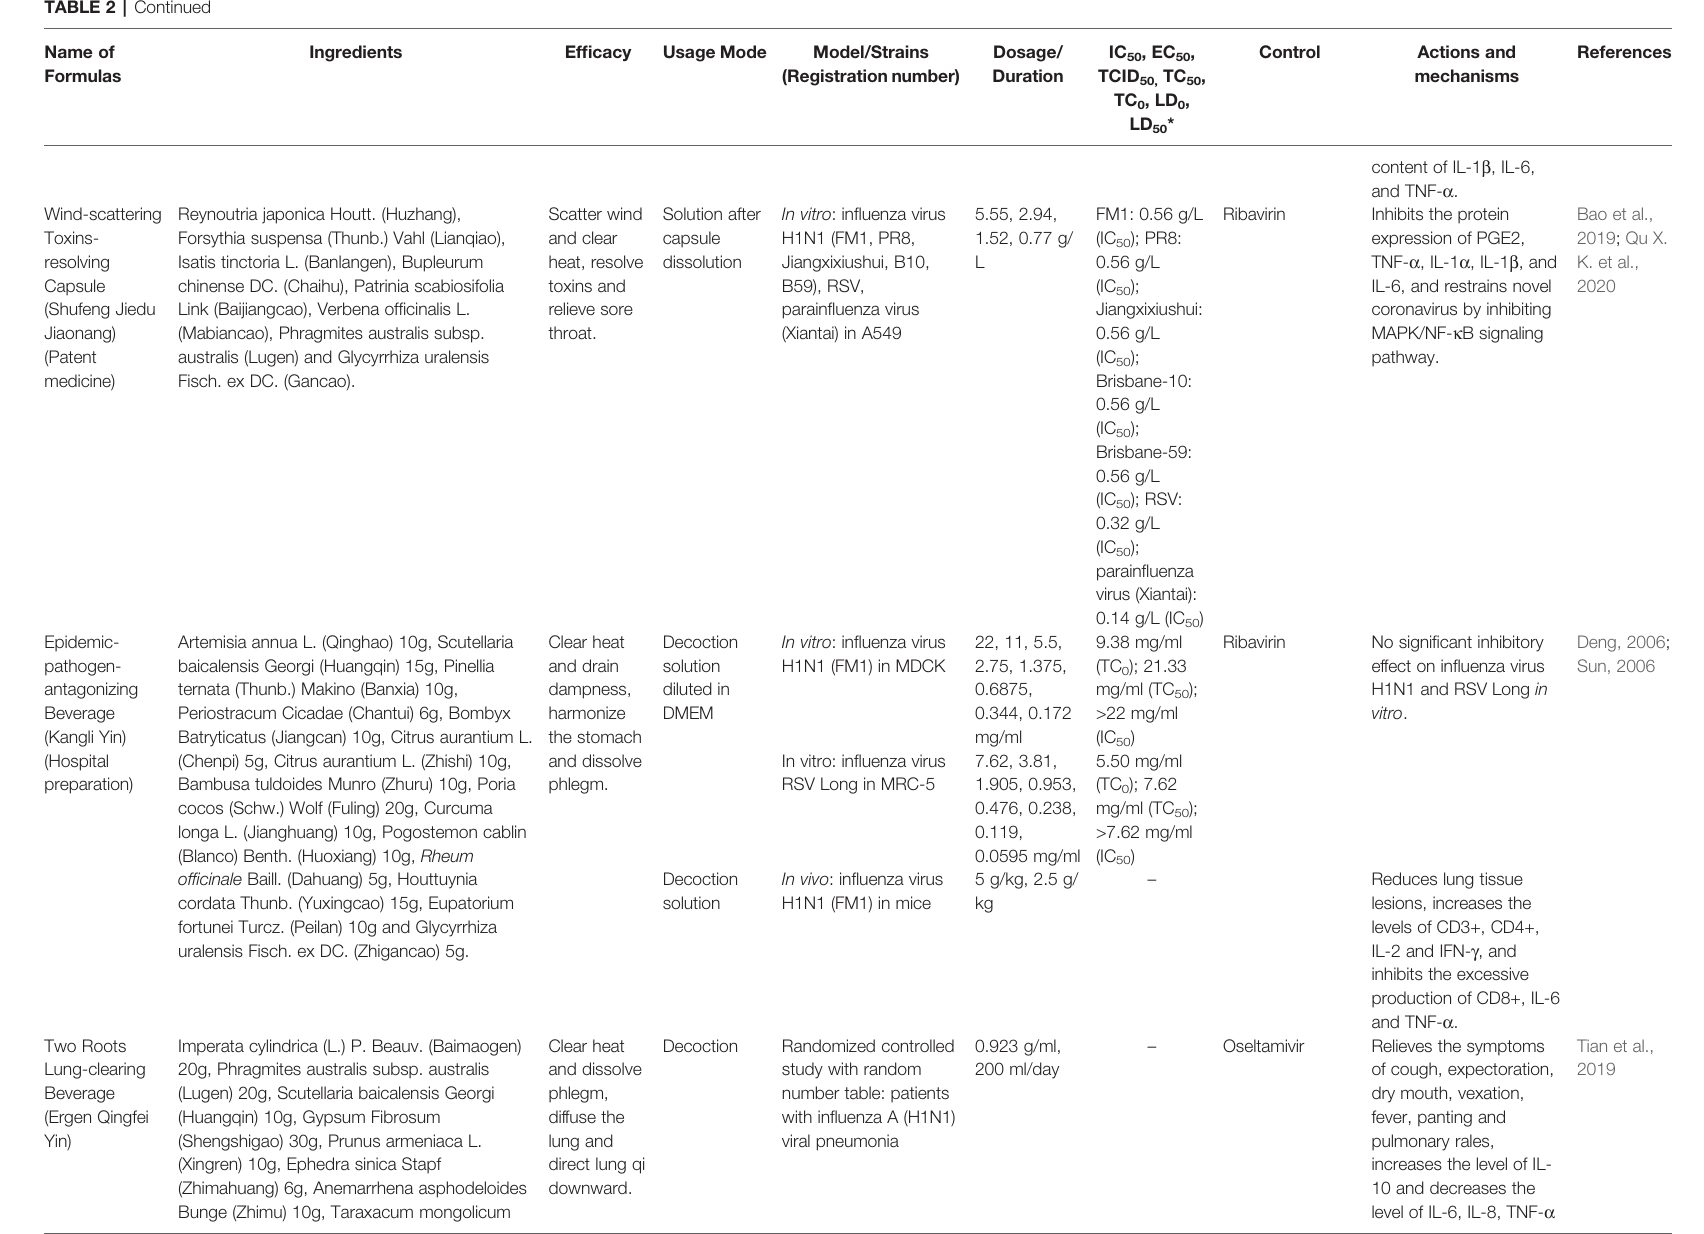
number table: patients with in fl uenza A (H1N1) viral